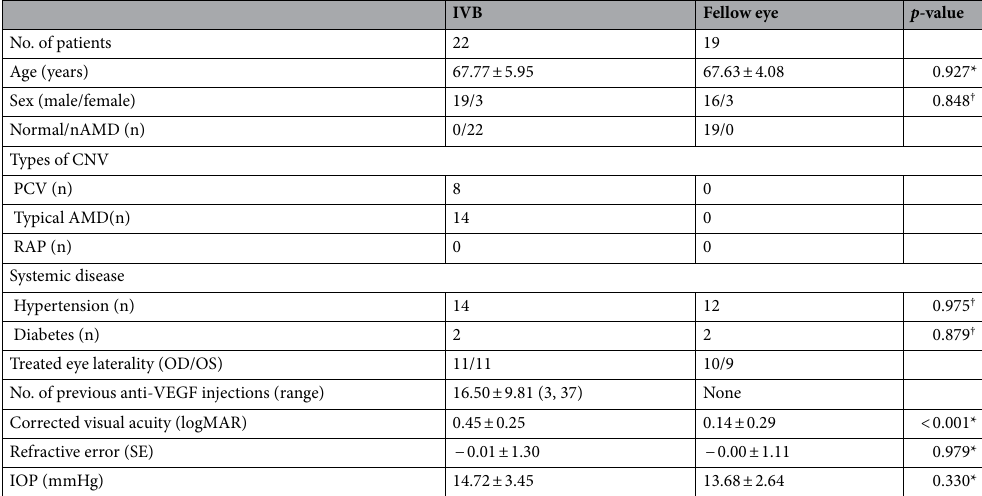
Table 1. Baseline characteristics of all eyes that received intravitreal brolucizumab injection and untreated fellow eyes. * p value derived from Mann–Whitney U -test. † p value derived from Pearson’s chi-square test; IVB, group that received intravitreal brolucizumab injection; nAMD, neovascular age-related macular degeneration; n, number; CNV, choroidal neovascularization; PCV, polypoidal choroidal vasculopathy; AMD, age-related macular degeneration; RAP, retinal angiomatous proliferation; OD, right eye; OS, left eye; VEGF, vascular endothelial growth factor; logMAR, logarithm of the minimum angle of resolution; SE, spherical equivalent; IOP, intraocular pressure.